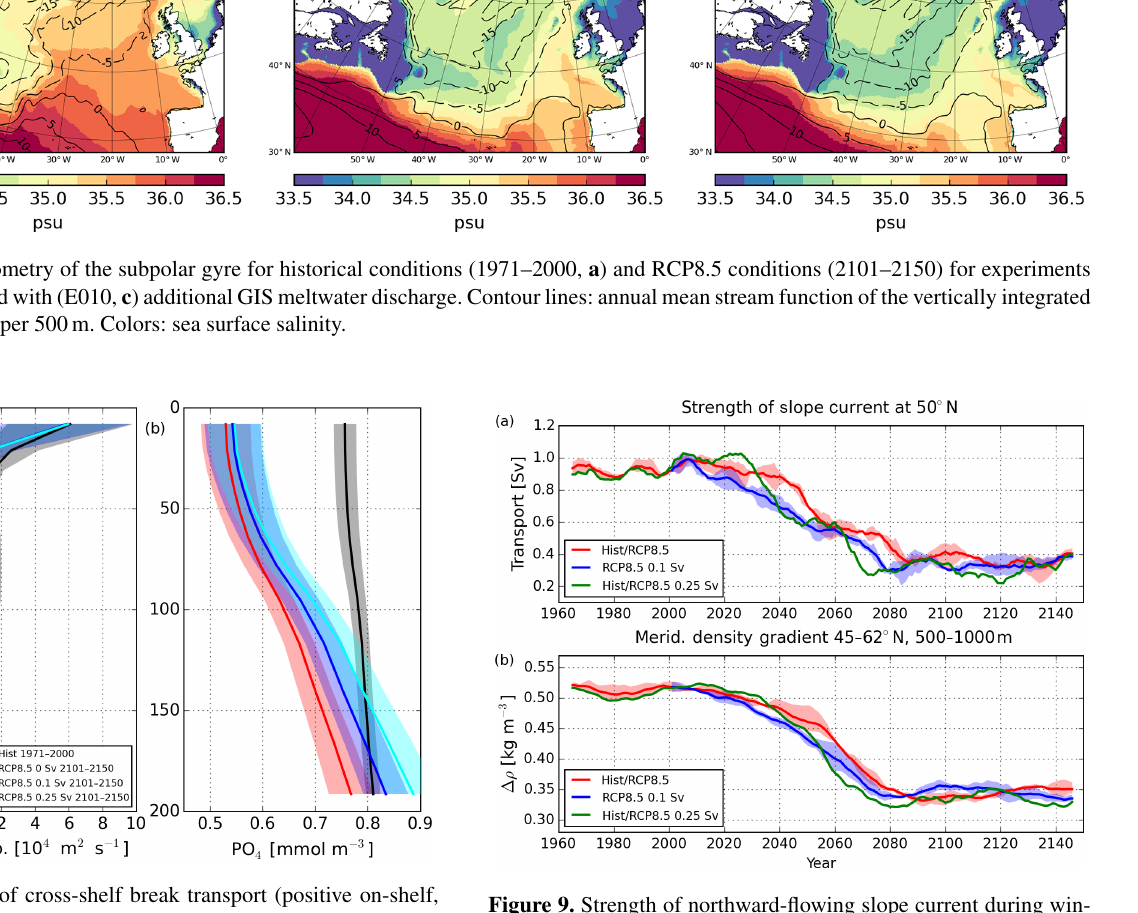
Figure 9. Strength of northward-flowing slope current during win- ter (DJFM) at 50 ◦ N (a) . Annual meridional density gradient in the NE Atlantic (45–62 ◦ N, 15–28 ◦ W) at 500–1000m depth (b) . Solid: control run C0 (gray), the ensemble means of experiments E0 (red) and E010 (blue), and a single realization of E025 (green). Shaded areas: ensemble